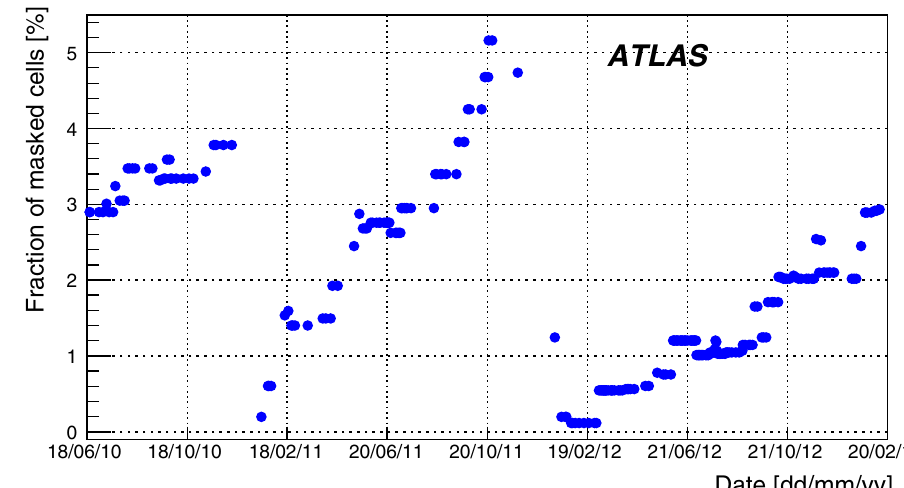
Fig. 21 The percentage of the TileCal cells that are masked in the reconstruction as a function of time starting from June 2010. Periods of recovery correspond to times of hardware maintenance when the detector is accessible due to breaks in the accelerator schedule. Each super-drawer LB (EB) failure corresponds to 0.43% (0.35%) of masked cells. The total number of cells (including gap, crack, and minimum-bias trigger scintillators) is 5198. Approximately 2.9% of cells were masked in February 2013, at the end of the